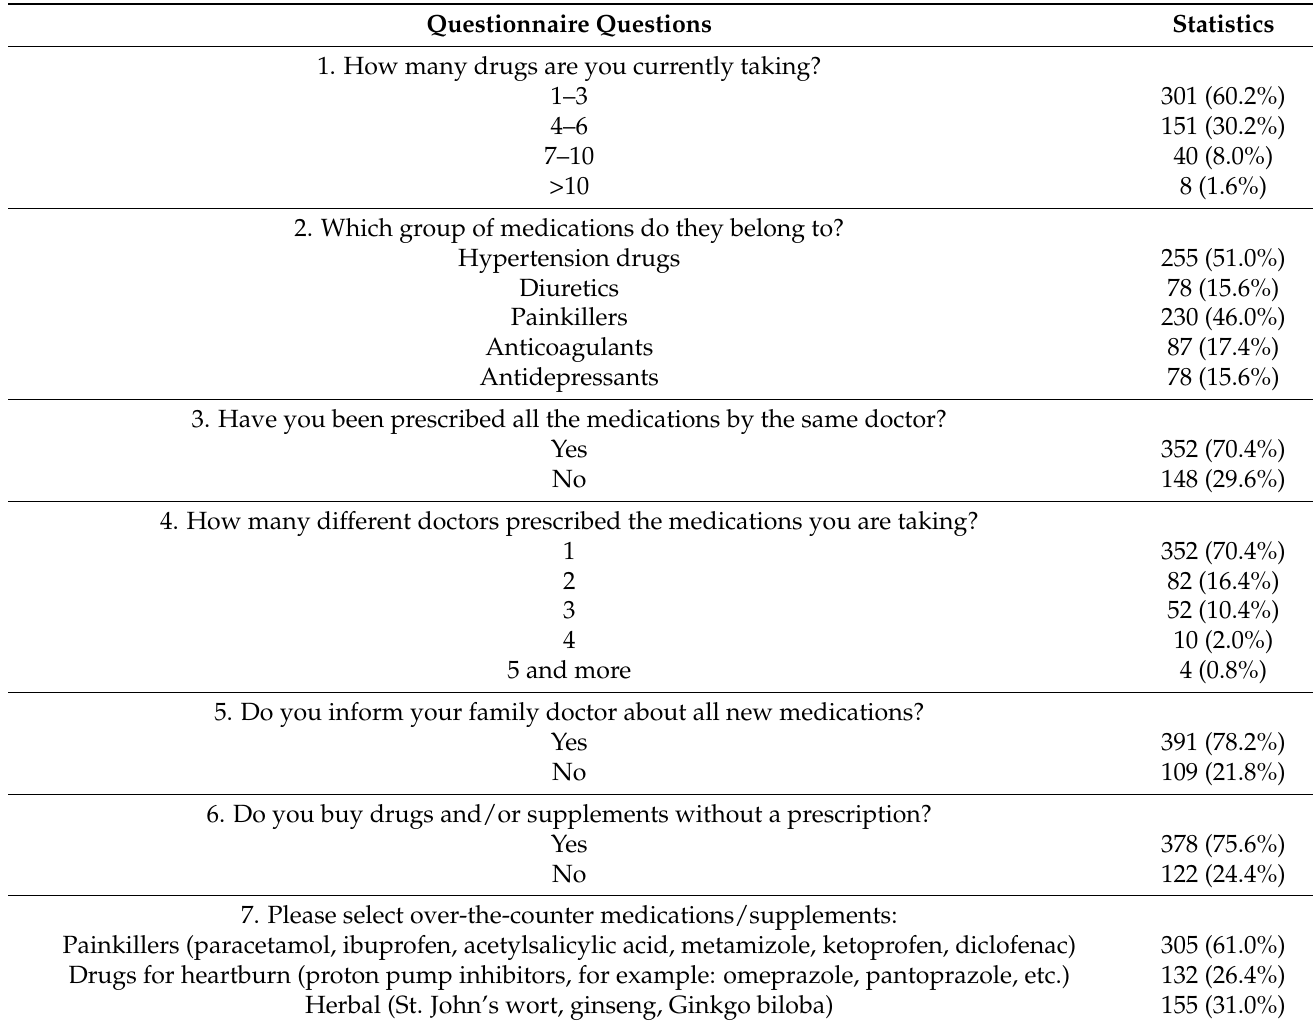
Table 3. Characteristics of pharmacological treatment of the studied